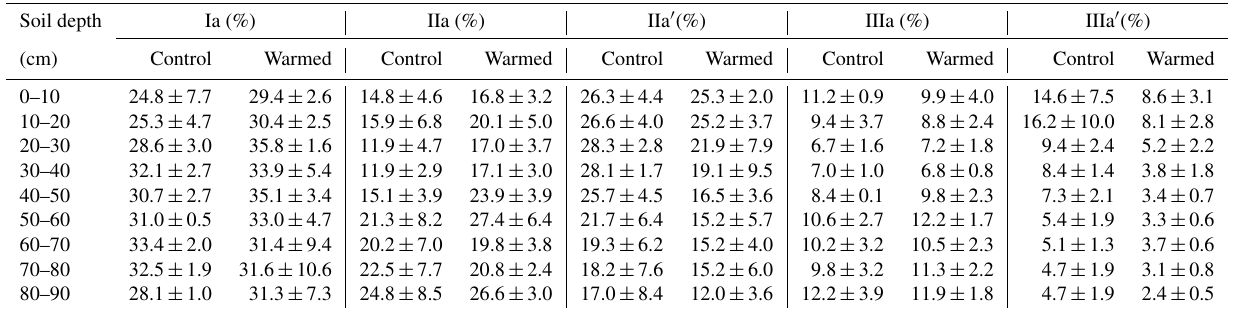
Table B4. Relative abundance of individual brGDGTs compared to the total in control plots and warmed plots (mean ± SE; n = 3). All compounds were included for the calculation, but only the five most abundant are shown in the